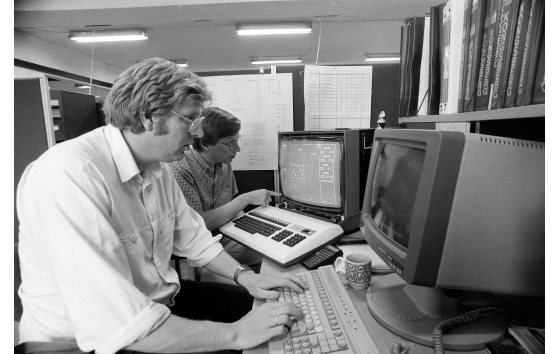
Figure 3: Nils Albert Jenssen, in the foreground, was central to the development of software for dy- namic positioning. Photo: